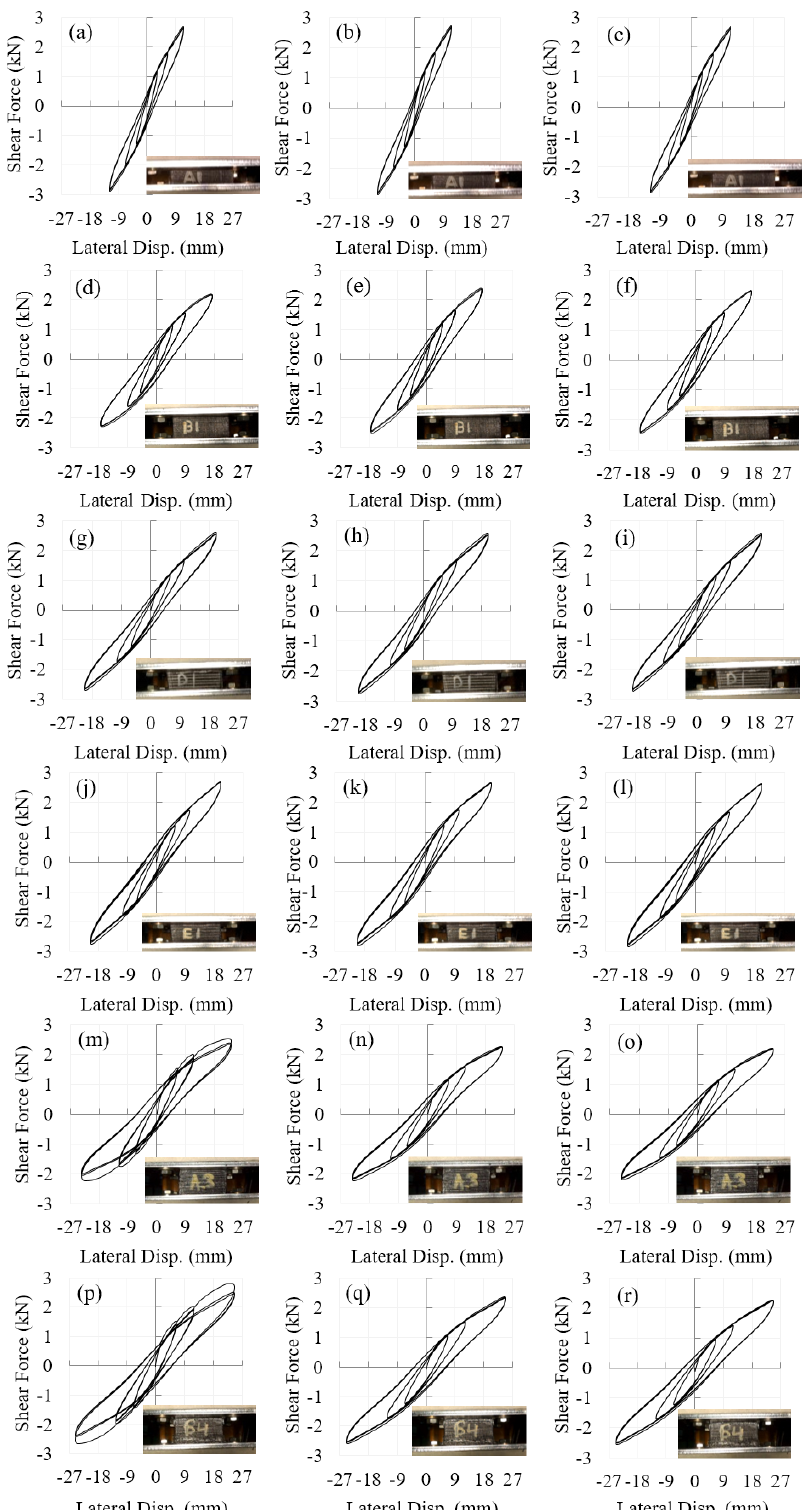
Figure 7. Hysteresis of C-FREIs under different vertical pressures ( P = 1, 2, and 3 MPa) and shear strains ( γ = 25%, 50%, and 100%); ( a ) A1 under 1MPa; ( b ) A1 under 2MPa; ( c ) A1 under 3MPa; ( d ) B1 under 1MPa; ( e ) B1 under 2MPa; ( f ) B1 under 3MPa; ( g ) D1 under 1MPa; ( h ) D1 under 2MPa; ( i ) D1 under 3MPa; ( j ) E1 under 1MPa; ( k ) E1 under 2MPa; ( l ) E1 under 3MPa; ( m ) A3 under 1MPa; ( n ) A3 under 2MPa; ( o ) A3 under 3MPa; ( p ) B4 under 1MPa; ( q ) B4 under 2MPa; ( r ) B4 under 3MPa.